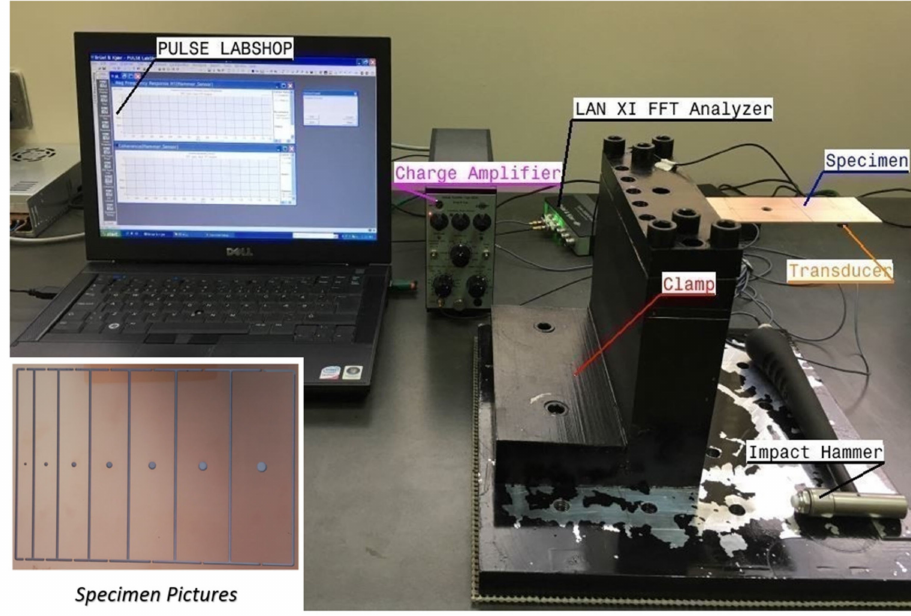
Figure 2. Photograph of the experimental setup and specimen pictures of Group